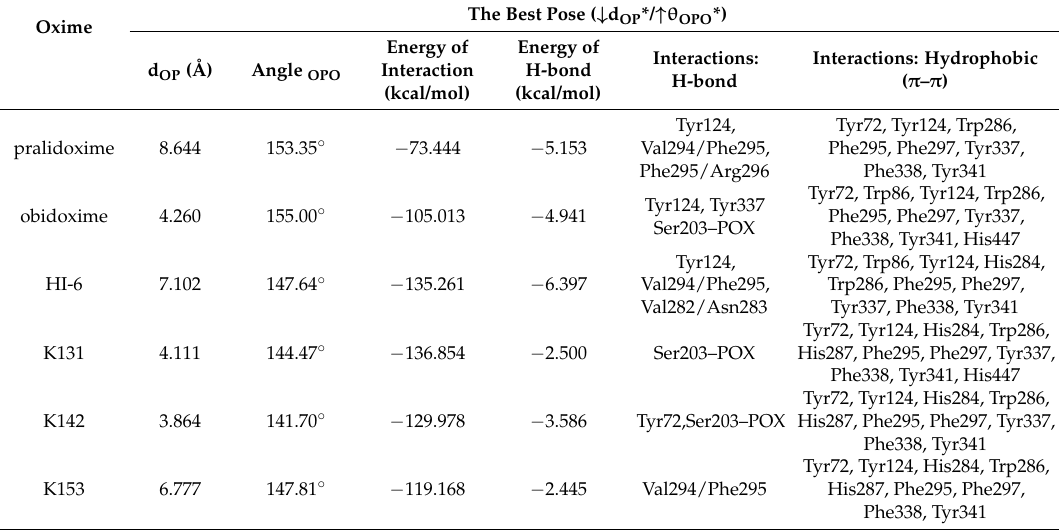
Table 2. Docking results for the complex Hss AChE/paraoxon